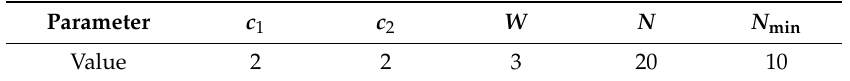
Table 2. Fundamental parameters for